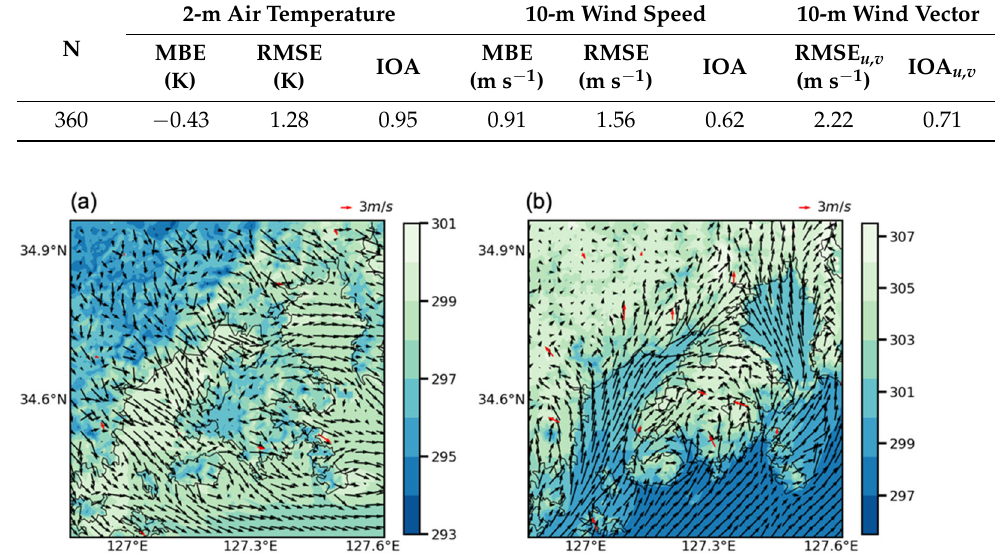
Figure 3. Mean diurnal variation of observed (OBS) and simulated (MOD) near-surface ( a ) air temperature ( T s ; K) and ( b ) wind speed ( WS s ; m s − 1 ) averaged at 15 AWS/ASOS stations in D04 on 15 July 2018. Table 3. Model evaluation statistics for near-surface variables against the observations from 15 AWS/ASOS stations in D04 on 15 July 2018. MBE, RMSE, and IOA indicate the mean bias error, root-mean-square error, and index of agreement, respectively. N represents the number of data.